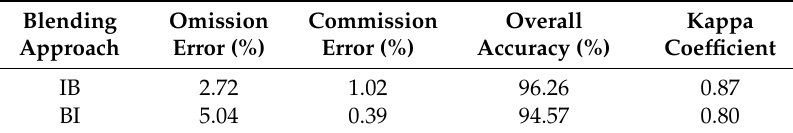
Figure 7. ( a ) Evaluation map of IB result; ( b ) evaluation map of BI result. Table 2. Accuracy evaluation results indicated by indices.